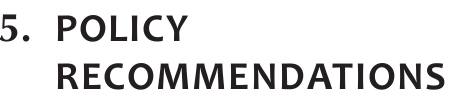
Table 3. The empirical results of economic, social, and institutional drivers’ influence on electricity production from oil, gas, and coal sources (% of total) in OECD countries Random-effects GLS regression Group variable: id R-sq: within = 0.2284 between = 0.0540 overall = 0.0347 corr(u_i, X) = 0 (assumed)